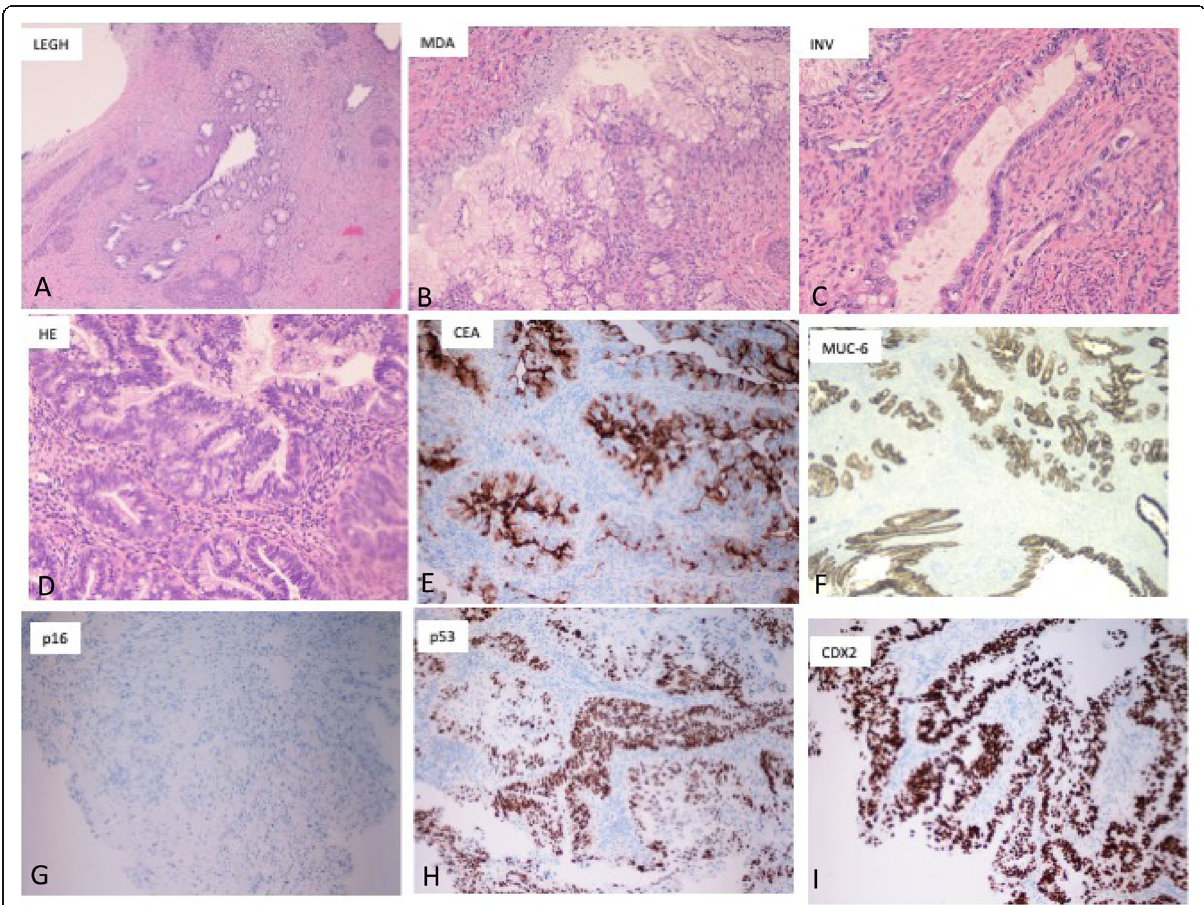
Fig. 2 Images from well-differentiated MDA (B), arising on the base of LEGH ( A ) with centrally dilated duct surrounded by small proliferating glands. B . MDA with intraluminal papillary infoldings lined by columnar pale cells with abundant mucin, distinct cell borders and very mild nuclear enlargement. C . Focus on stromal invasion by single and small clusters of neoplastic cells. D . HE of moderately-differentiated GAS with columnar pale to eosinophilic cells with nuclear enlargement, stratification and hyperchromasia. Dispersed goblet cells are present Single images of IHC with different antibodies E . CEA, F . MUC-6 G .p16 H .p53 and I